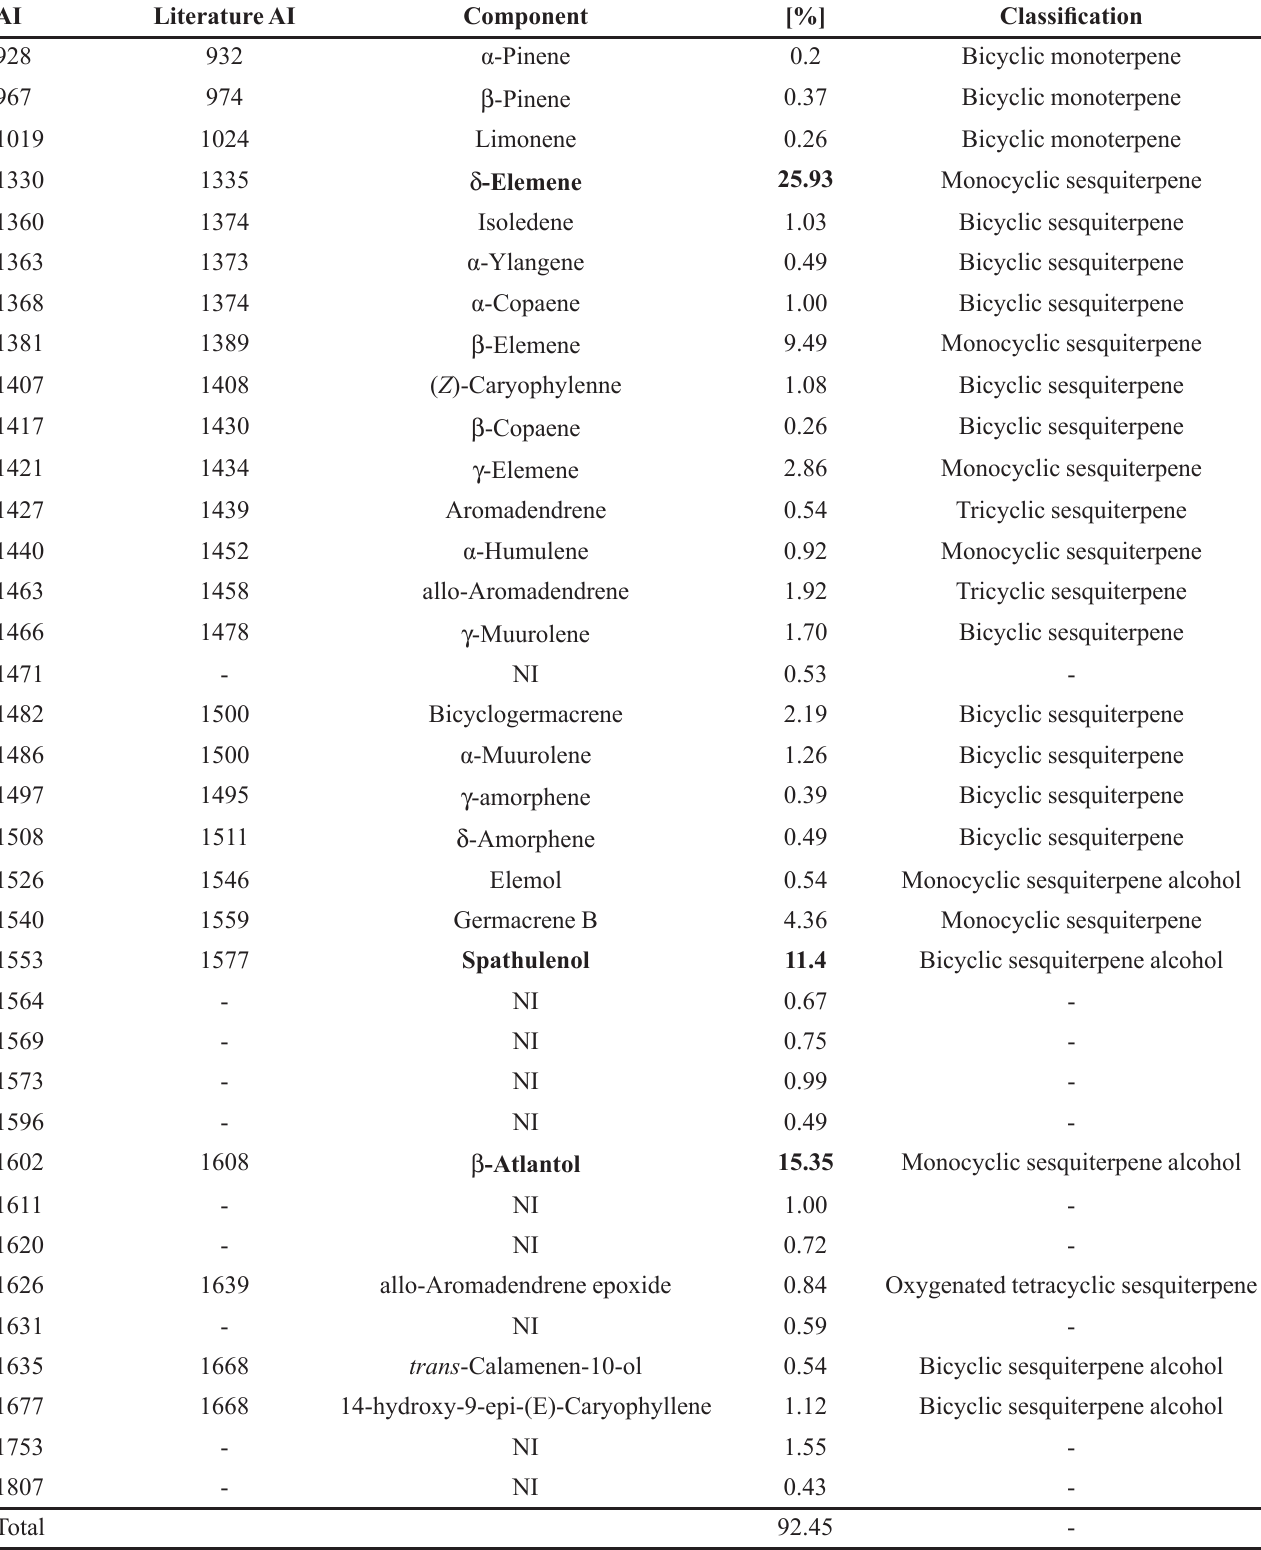
TABLE I - Composition of the essential oil of Ocotea diospyrifolia (Meisn.) Mez. leaves extracted via